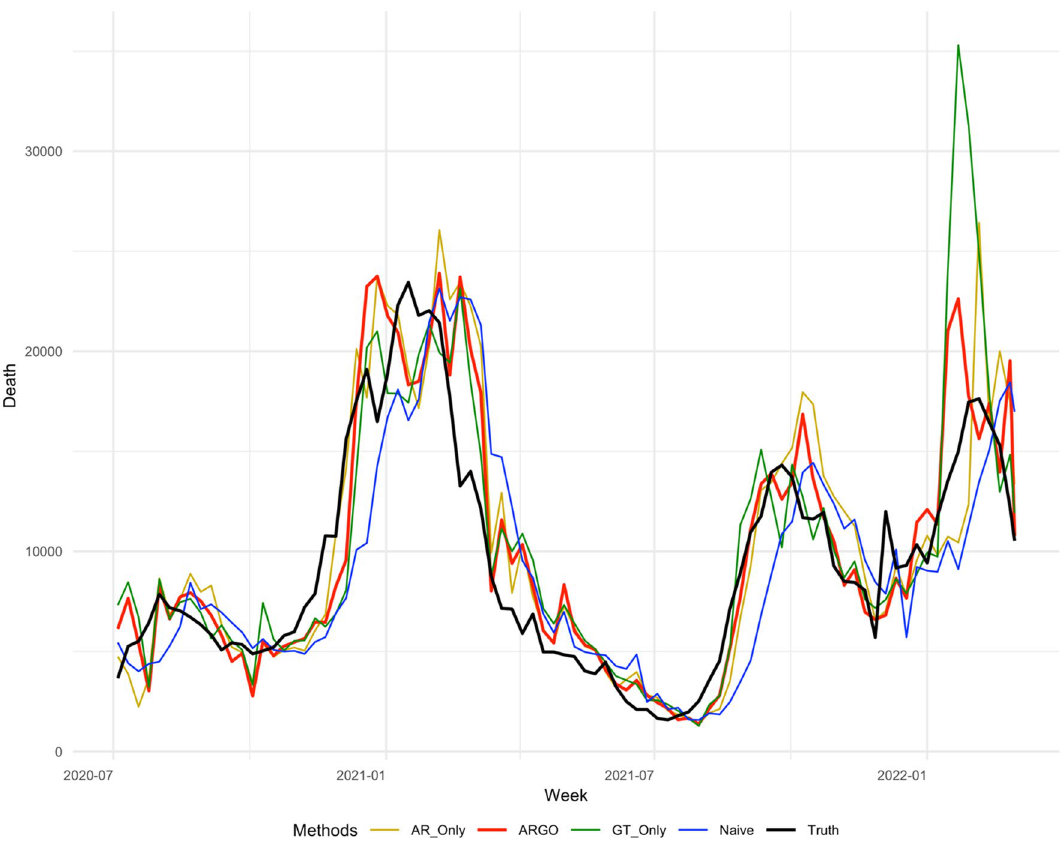
Figure 5. 3 weeks ahead national level COVID-19 weekly incremental death predictions’ comparisons weekly from 2020-07-04 to 2022-03-05. The method included are AR-Only (gold), ARGO (thick red), GT-Only (Green), Naive (blue), truth (thick